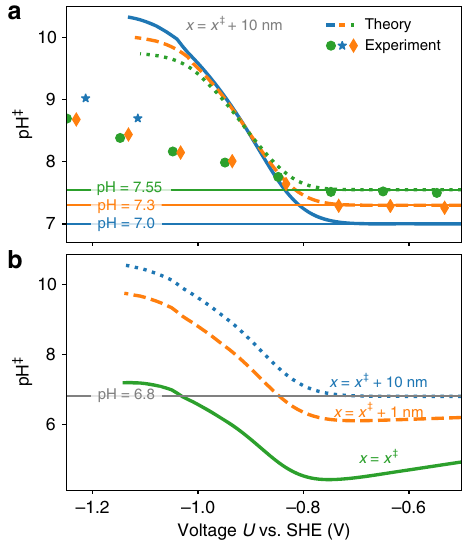
Fig. 7 Voltage dependence of the local pH. a Local pH at the ENP (10 nm) as a function of electrode potential as predicted by the coupled microkinetic mass transport modeling scheme using CatINT (solid lines) and ATR- SEIRAS spectroscopy (symbols) of ref. 14 for three different bulk pH values. b Modeled local pH at three different distances from the electrode, the reaction plane (RP, z ), 1 nm distance, and 10 nm distance (electroneutrality plane, ENP). The horizontal line indicates the bulk pH of the simulations and